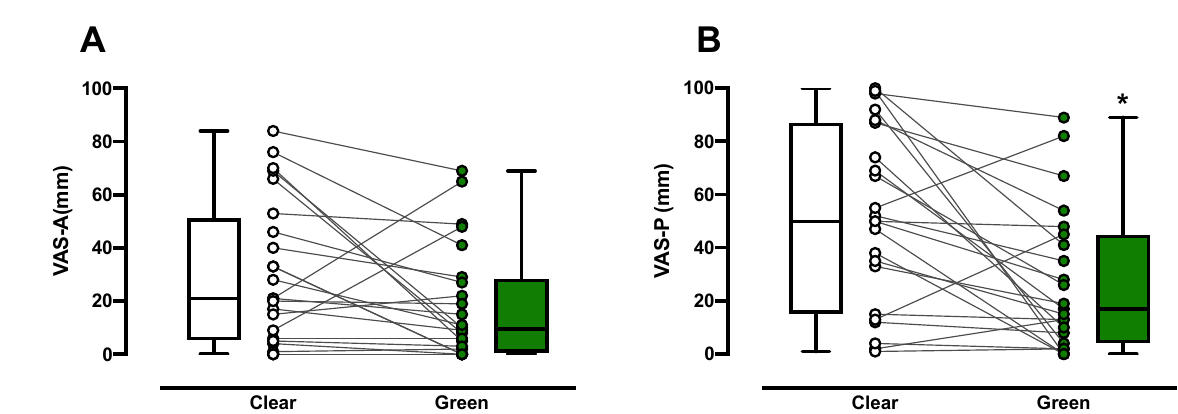
Figure 3. Self-evaluated anxiety and pain during peripheral intravenous cannulation using a visual analog scale for anxiety (VAS-A, 0, no anxiety; 10, worst imaginable anxiety) and for pain (VAS-P, 0, no pain; 10, worst imaginable pain) in the clear control group ( n = 24) and green group ( n = 23). Medians, quartiles, and ranges are represented by boxes with corresponding individual values on the VAS-A ( A ) and VAS-P ( B ). * p = 0.011.